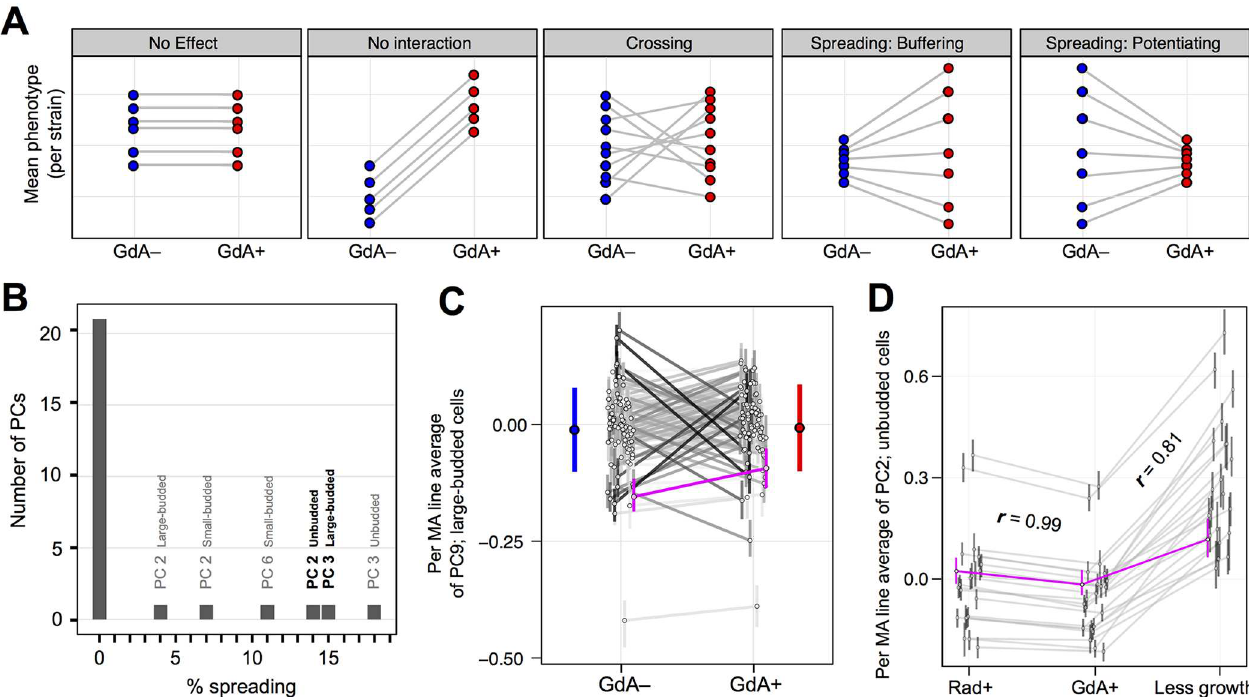
Fig 4. Epistatic interactions between Hsp90 and spontaneous mutations do not often involve buffering or potentiation. (A) Models of the different effects that Hsp90 might have on phenotypicvariation between strains are shown. Each plot displays medianphenotypeper strain in GdA − (blue circles) and GdA+ (red circles); each line connecting two circles follows the change that Hsp90 inhibitionhas on a given strain. When lines have different slopes, GdA has a genotype-specific effect (rightmost 3 models). Line-crossing epistasis can be distinguished from buffering or potentiating, which are line-spreading subtypes of epistasis. (B) Line-crossing epistasis is far more prevalent than buffering or potentiation between Hsp90 and the spontaneousmutations present in the MA lines. The horizontal axis represents the fraction of the interaction between GdA and genotype that can be explainedby line spreading (as opposed to line crossing); the vertical axis represents the number of PCs that fall into each bin, where bin width is 1%. PCs for which line spreading contributes > 1% of this interactionare labeled;bold-labeled PCs are those plotted in Fig 3A and 3B. (C) An example phenotypefor which line crossing contributes > 99% (spreading contributes < 1%) of the interaction between GdA and MA lines. These data are plotted as in Fig 3A. (D) The effects of GdA on MA line morphology are more similar to the effects of another Hsp90 inhibitor radicicol (Rad) than they are to the effects of abbreviatedgrowth. Displayedplots are similar to those in Fig 3A, except here they show a random subset of 22 MA lines that were imaged after growth in GdA, Rad, and in a “less growth” conditionin which we reduced the durationof exponential phase from 6 to 4 h (see Experimental Procedures ). This PC was chosen because both correlationcoefficients ( r ) are close to their medianvalues across all 29 PCs (for all PCs, see S4